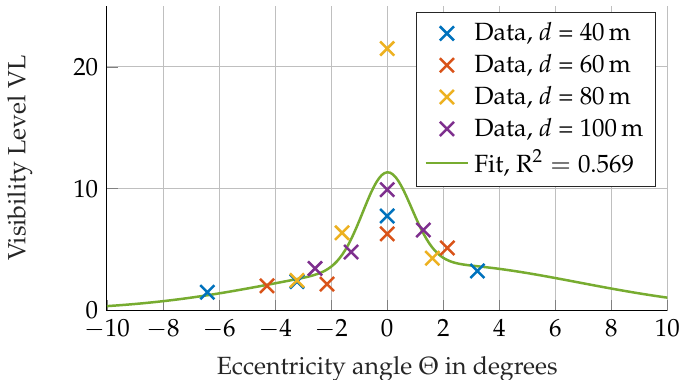
Figure 11. Angular dependence of the Visibility Level VL; as the eccentricity angle Θ increases, the required Visibility Level for reliable object detection